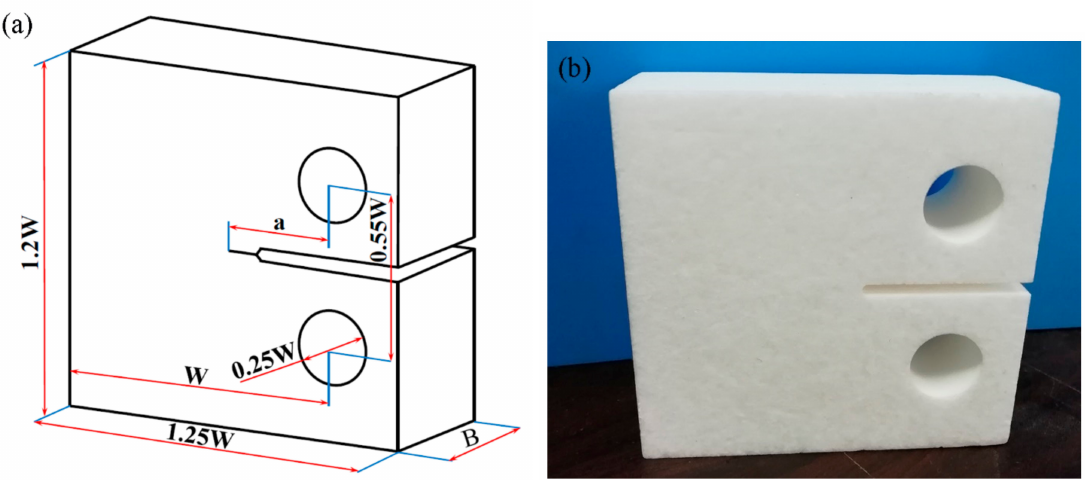
Figure 2. ( a ) CT specimen schematic diagram ( B is the specimen thickness, B = W / 2, B = 25 mm, the pre-crack length a is 20 or 25 mm, then a / W = 0.4 or 0.5) and ( b ) is a photo of the CT